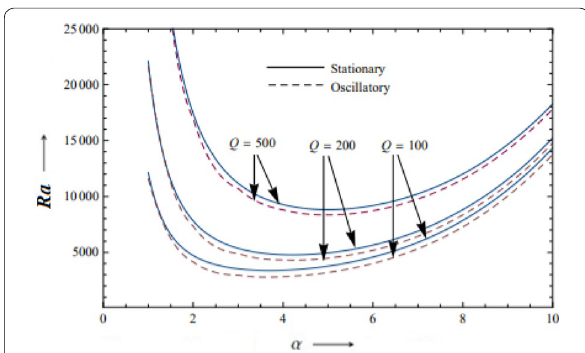
Fig. 6 Effect of magnetic field parameter on Rayleigh number [101]